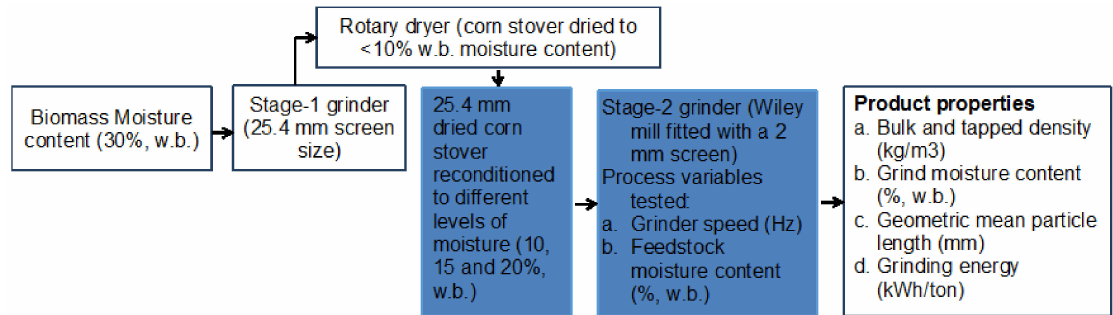
Figure 3. A flow diagram of the grinding studies conducted in the present research.